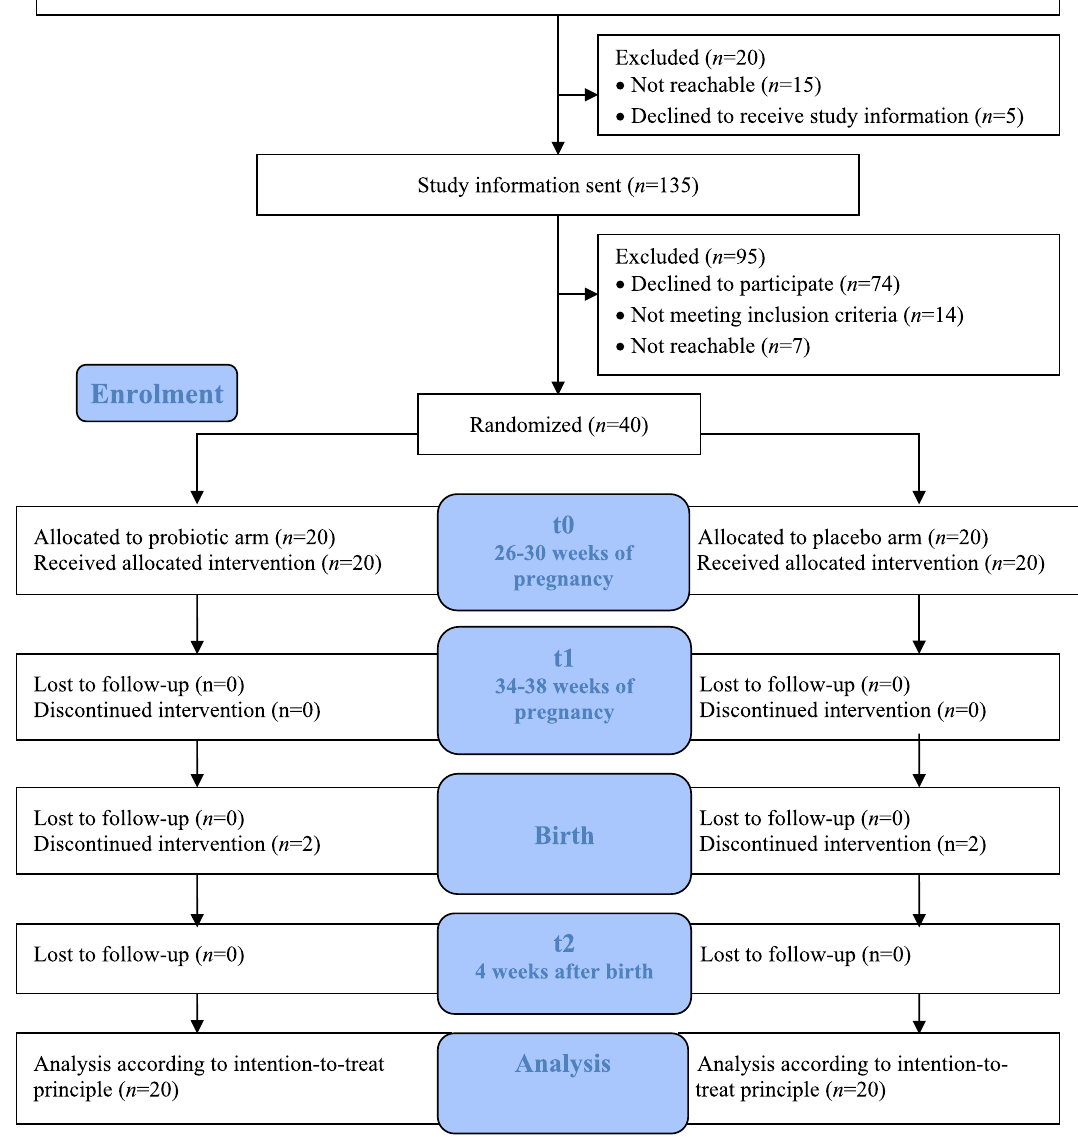
Figure 1. Participants’ flow through the study based on the Consolidated Standards of Reporting Trials (CONSORT) flow diagram. From the research database, participants were screened for eligibility and contacted by phone by the coordinating investigator whether they wanted to receive study information. Eligible participants who provided consent were randomized in either the probiotic or placebo group (t0). Measurements took place between baseline (t1) and 4 weeks post-partum (t2). Participants were recruited from March 2017 to September